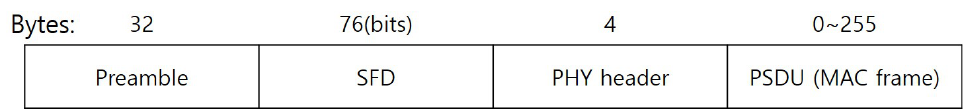
Figure 9. PHY frame format.